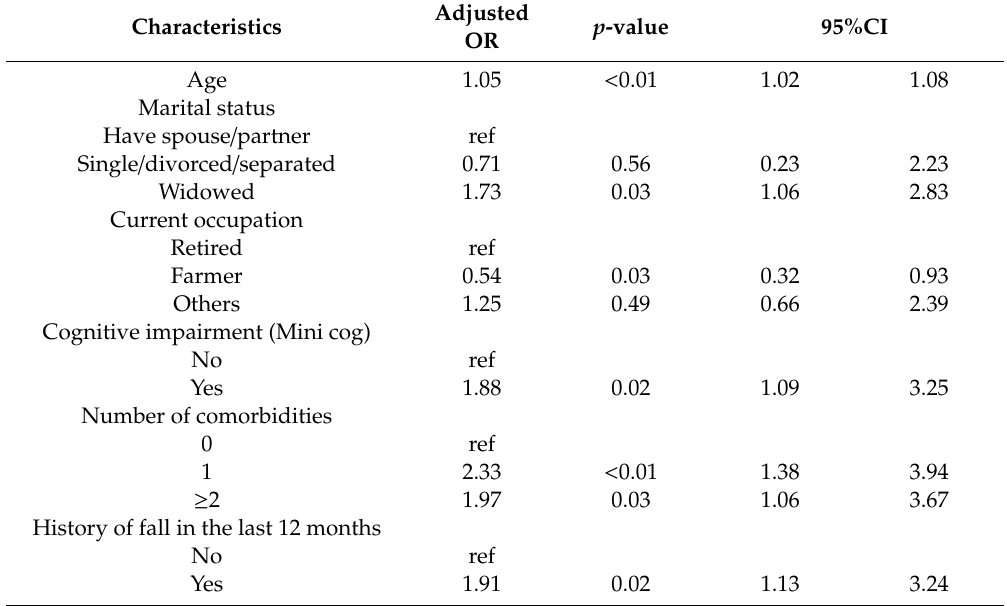
Table 3. logistic regression models to identify associated factors with having frailty. OR: odds